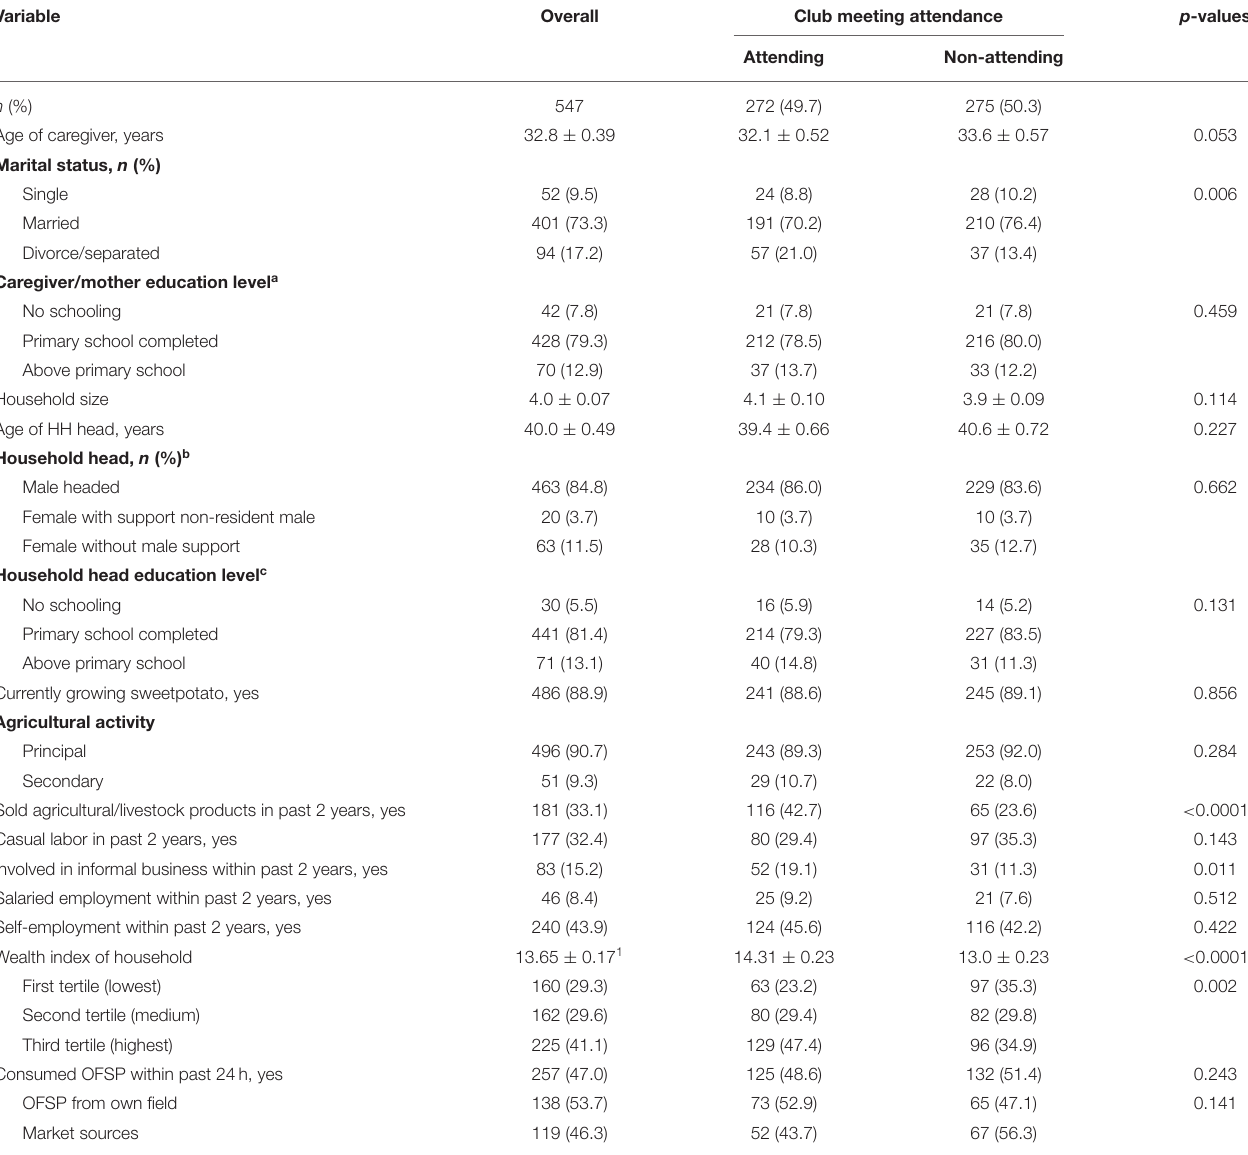
TABLE 1 | Participant and household demographics by whole sample and nutrition group club